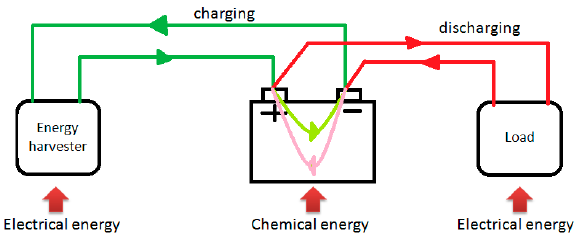
Figure 8. Energy conversion between charging and discharging of the battery.